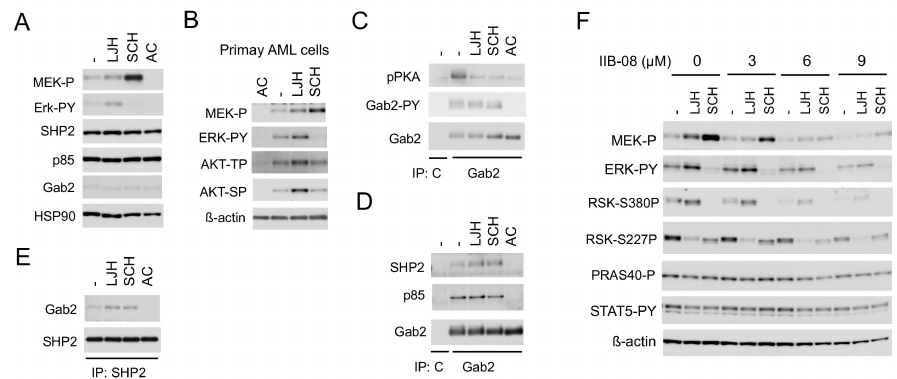
Figure 4. SHP2 interacting with Gab2 mediates activation of the MEK / ERK pathway and its negative feedback regulation by RSKs in in FLT3-ITD-positive AML cells. ( A , C–E ) MV4-11 cells were treated for 2 h with 5 µ M LJH685 (LJH), 0.5 µ M SCH772984 (SCH), or 10 nM quizartinib (AC), as indicated, and lysed. Cell lysates were subjected to immunoprecipitation with anti-Gab2, anti-SHP2, or control murine IgG (C), as indicated. Total cell lysates or indicated immunoprecipitates (IP) were subjected to immunoblot analysis, as indicated. Abbreviations: MEK-P, phospho-S217 / 221-MEK; ERK-PY, phospho-T202 / Y204-Erk; pPKA, phospho-S / T-PKA substrates; Gab2-PY, phospho-Y452-Gab2. ( B ) Primary FLT3-ITD-positive AML cells were treated for 16 h with or without 20 nM quizartinib or 5 µ M LJH685, as indicated, and analyzed. Abbreviations: AKT-TP, phospho-T308-AKT; AKT-SP, phospho-S473-AKT. ( F ) MV4-11 cells were pretreated for 15 min with indicated concentrations of IIB-08 and then treated for 30 min with or without 2.5 µ M LJH685 or 0.5 µ M SCH772984, as indicated, for immunoblotanalysis. Abbreviations: RSK-S380P,phospho-S380-RSK1; RSK-S227P,phospho-S227-RSK2; PRAS40-P,